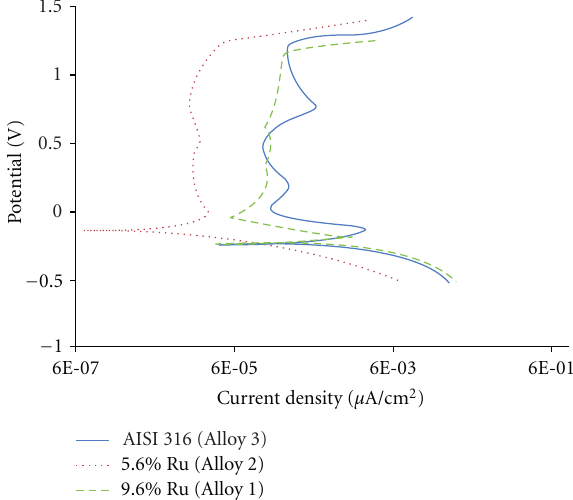
Figure 4: Comparison of potentiodynamic polarization curves for AISI 316 SS substrate, 5.6 wt% Ru steel and 9.6 wt% Ru